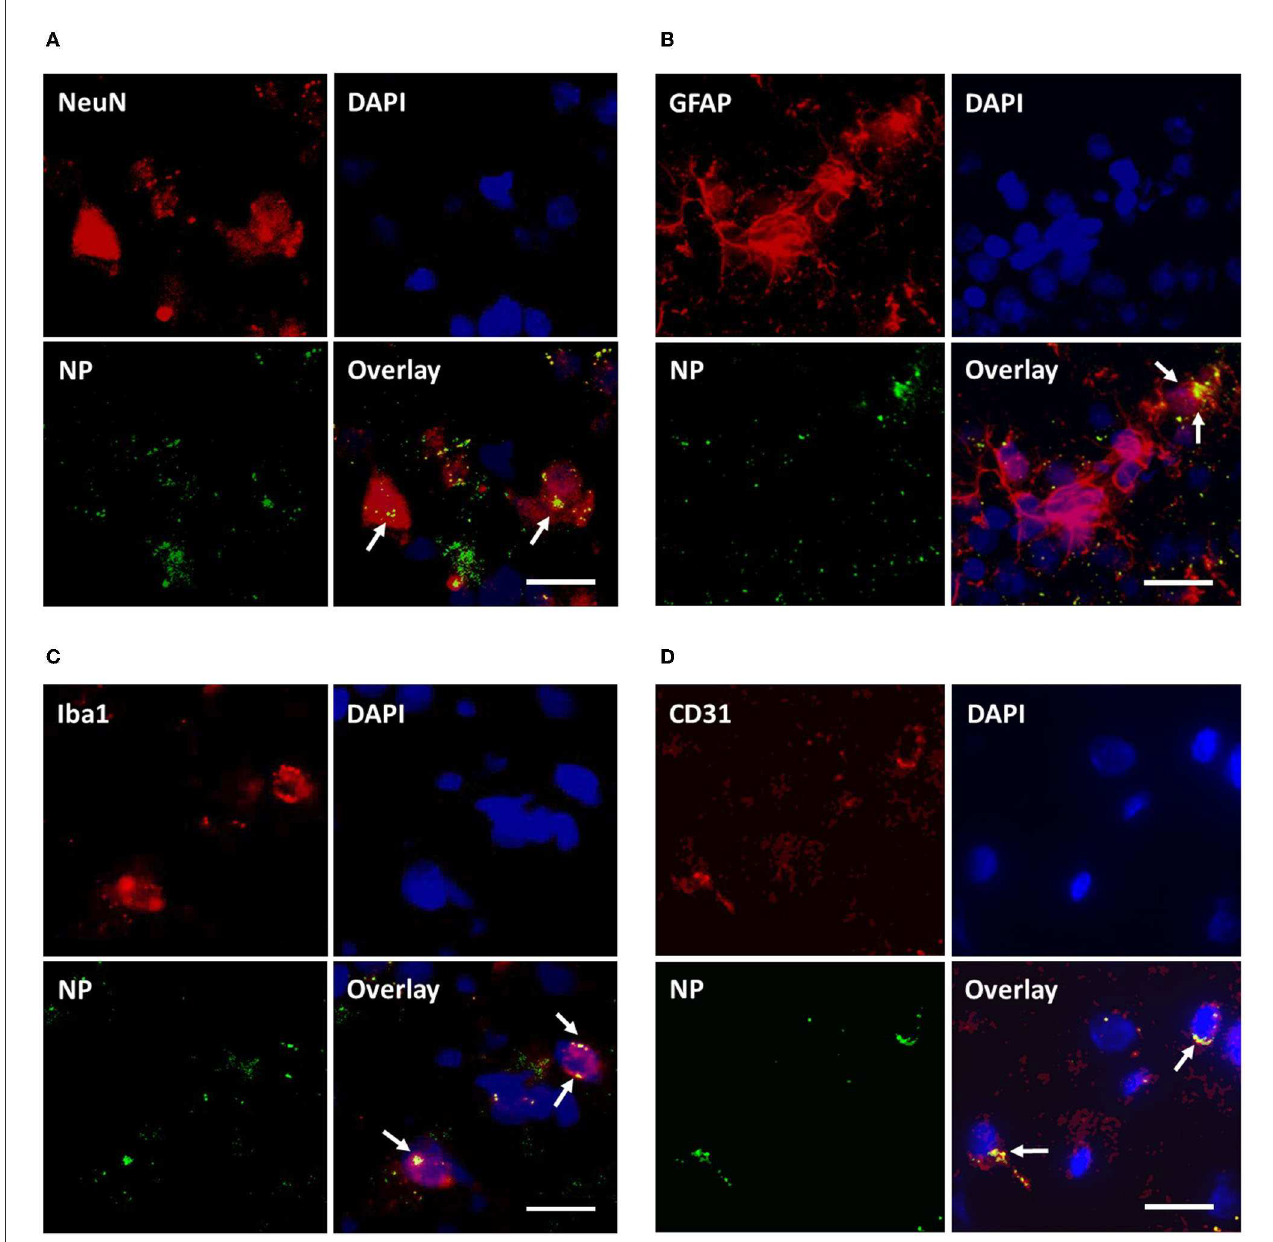
FIGURE10 Assessment of cellular uptake of PLLA-SDS by fluorescence microscopy. NP internalization into neurons, astrocytes, microglia and brain capillary endothelial cells was qualitatively studied by assessing the co-localization of NP-green fluorescence with red-fluorescence of antibodies against